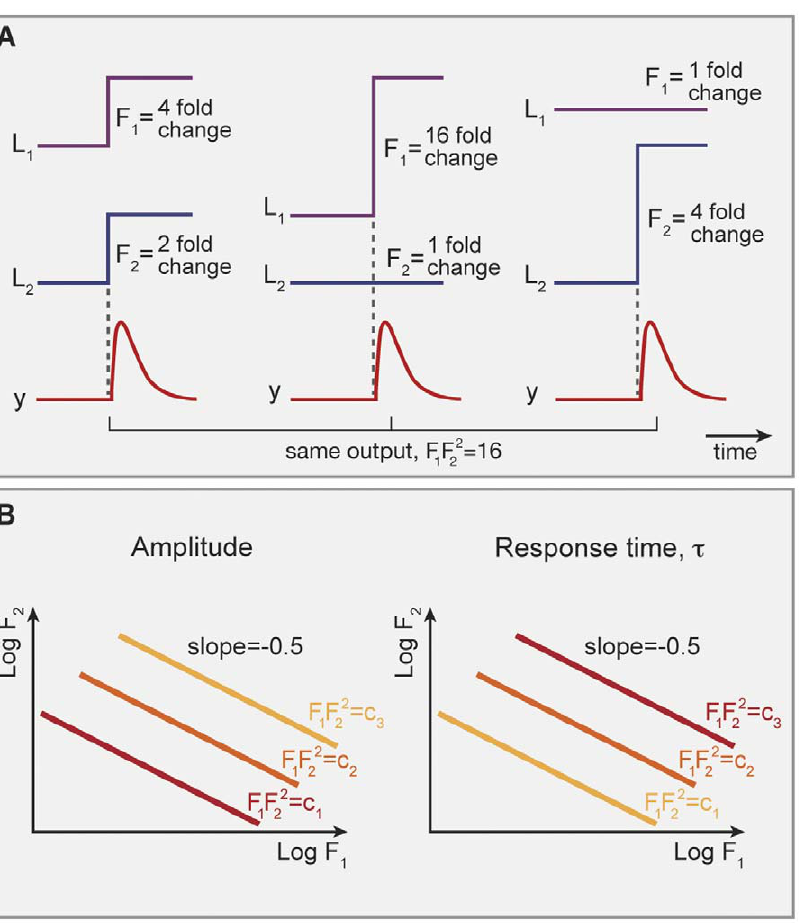
Figure 4. Power-law product rule for integration of two input signals in an FCD system, where both inputs bind the same receptor with different number of sites. (A) Let L 1 have one binding site, and L 2 have two sites. Response to simultaneous steps of L 1 and L 2 of folds F 1 and F 2 is dependent only on F 1 F 22 . Thus, steps with F 1 =4 and F 2 =2 shows the same output dynamics as two steps with F 1 =16 and F 2 =1 or two steps of F 1 =1 and F 2 =4, since in all cases F 1 F 22 ~ 16 (B) Linear equi-response contours in the (log F 1 , log F 2 ) plane. With increasing values of F 1 F 22 - amplitude rises (red to yellow) and response time decreases (yellow to red).